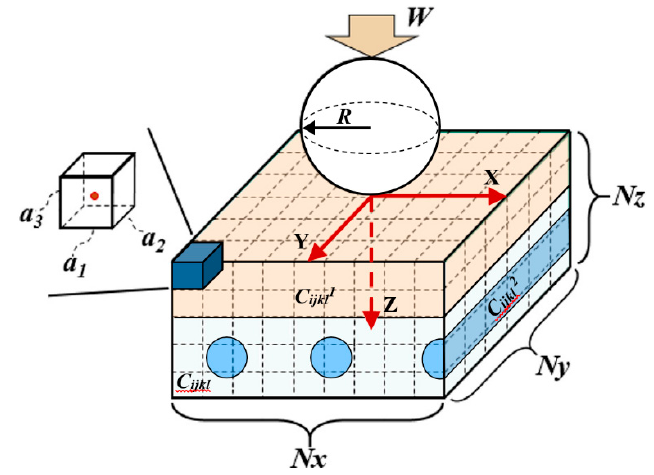
Figure 14. Inhomogeneous material subjected to sphere-plane contact loading containing a layered inhomogeneity and multiple cylindrical inhomogeneities. The element at the top left corner of the half space is magnified to display the definition of an element by its edges, a 1 – a 3 .